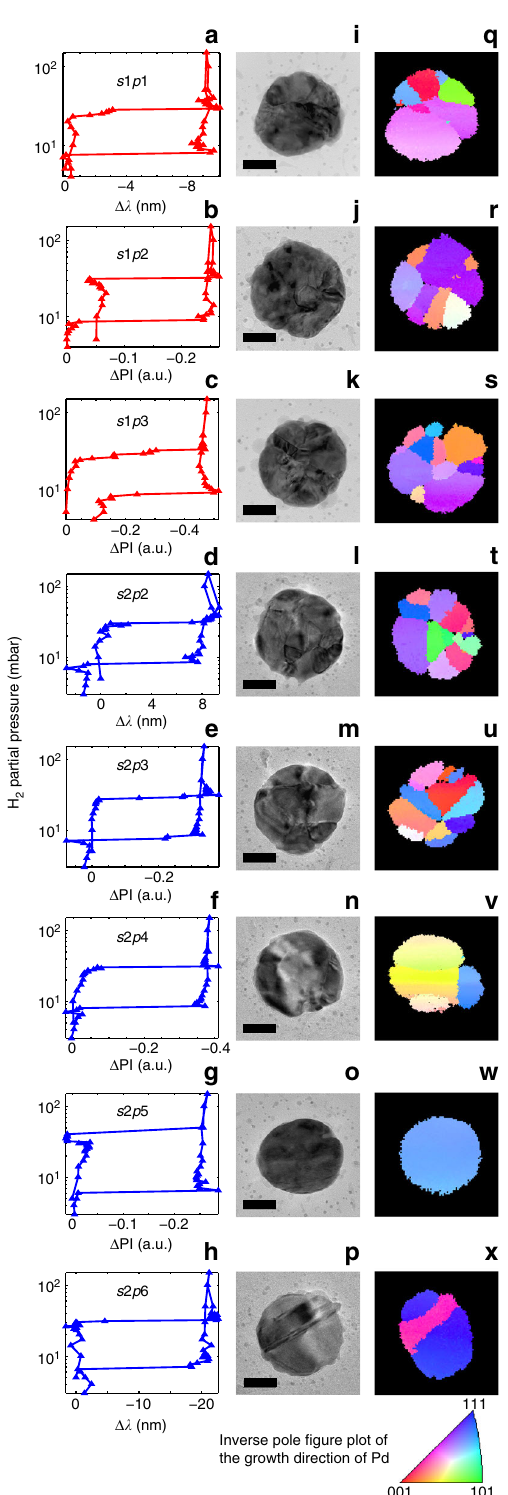
Inverse pole figure plot of the growth direction of